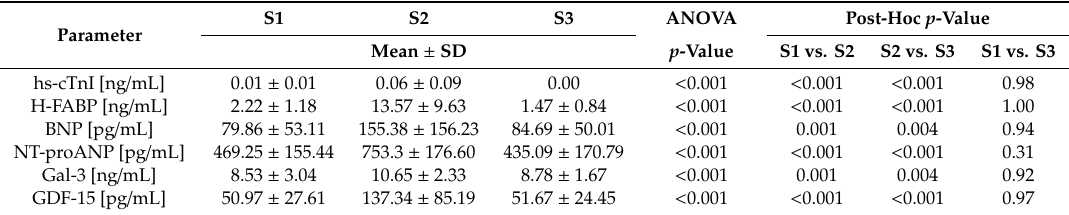
Table 3. Concentrations of cardiac injury and overload biomarkers: 2–3 weeks before the marathon (S1), on the finish line (S2) and 2–3 weeks after the marathon (S3). S1 S2 S3 Parameter